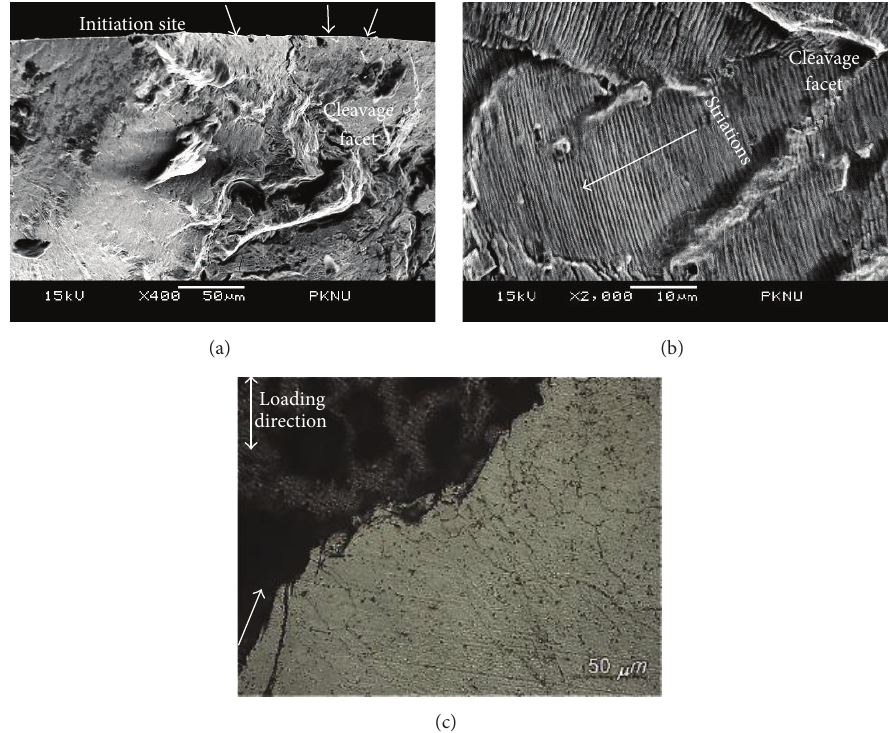
Figure 11: (a) SEM fractograph; (b) the crack propagation stage; (c) OM view of the fracture surfaces for Alloy 617 WJ tested at 0.6% total strain range.